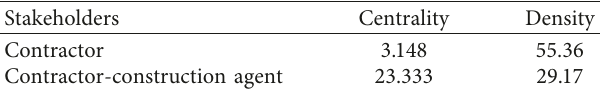
Table 4: Comparison of centrality and density between the two modes.